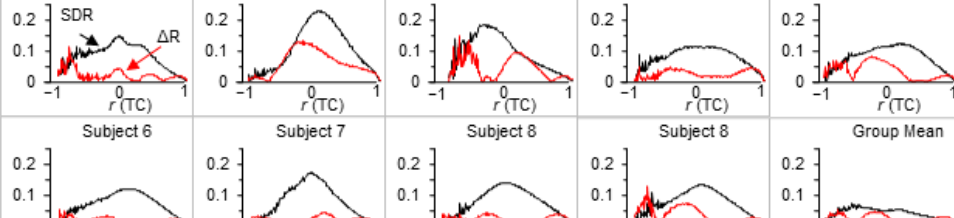
that of the absolute value of the difference between 𝑅 𝑟 and R ( r ) , i.e., Δ R = | 𝑅 𝑟 − R ( r )|, for each brain state of each subject and the group mean as well. TC: temporal correlation.